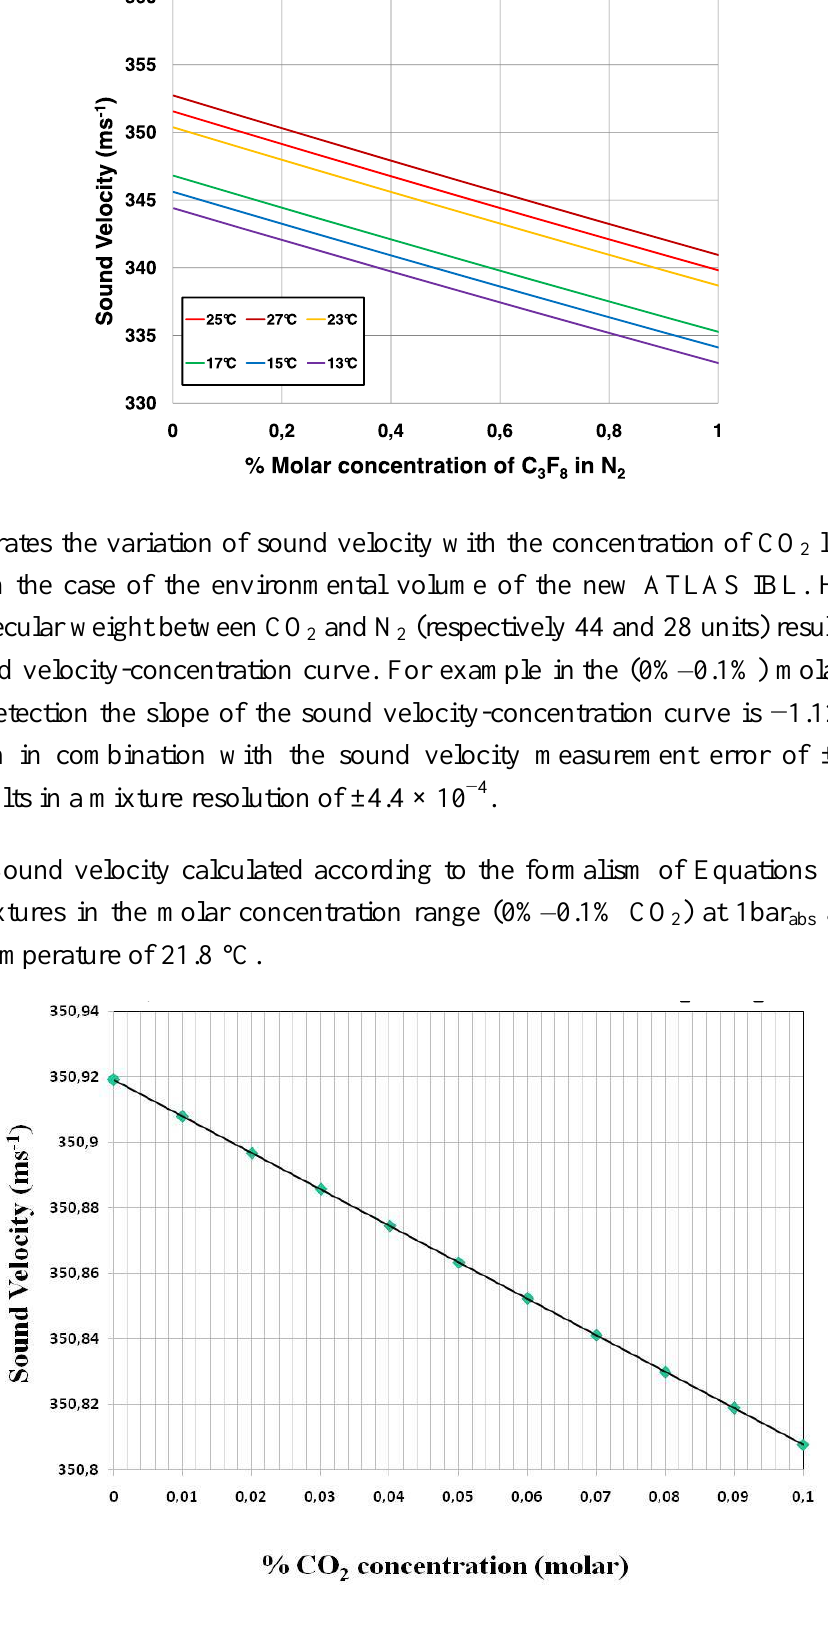
Figure 8. Sound velocity calculated according to the formalism of Equations (1)–(6) for